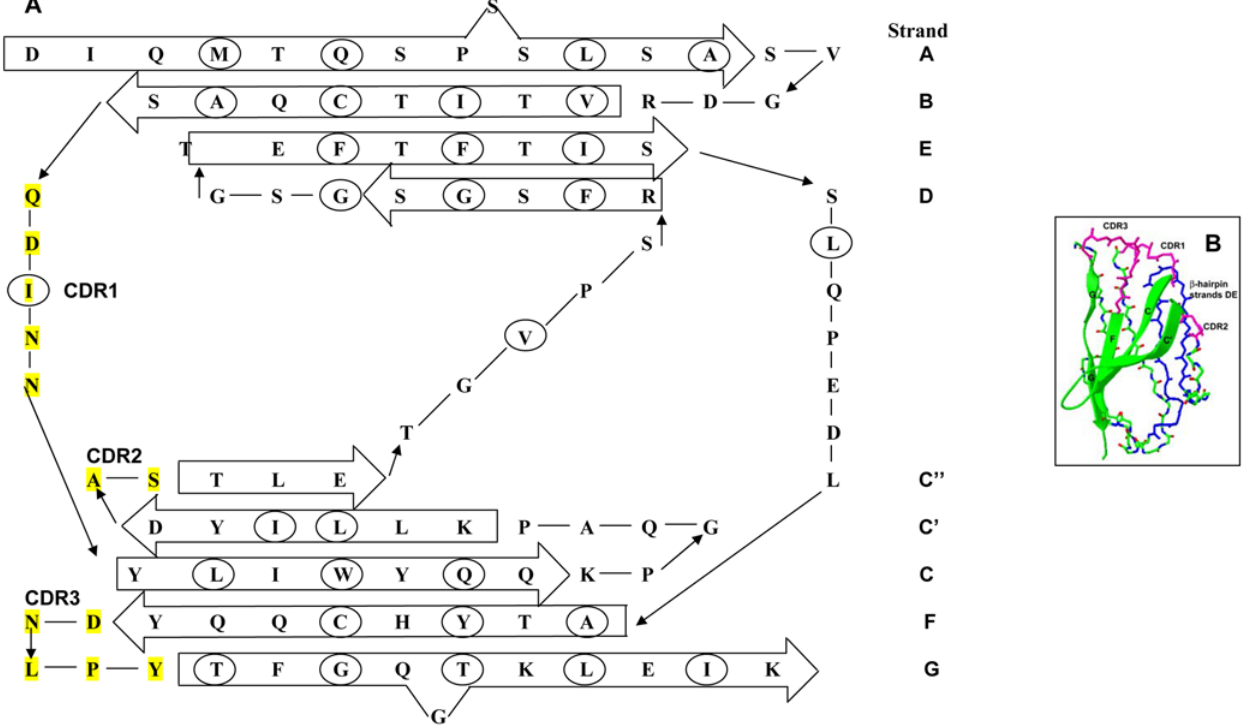
Figure 1. VL structure. A) Topological Diagram of the protein structure for AF490909 adapted from Schiffer, et al [28]. The two b -sheets of the domains have been separated. Residues that point towards the core are circled. CDR segments are highlighted in yellow. The b -strands have been encased within the arrows and are connected to their respective loops. B) Structural model of a VL (1BRE.pdb) showing CDR regions in pink, b -hairpin between strands D and E in blue and dimer interface in green ribbons.